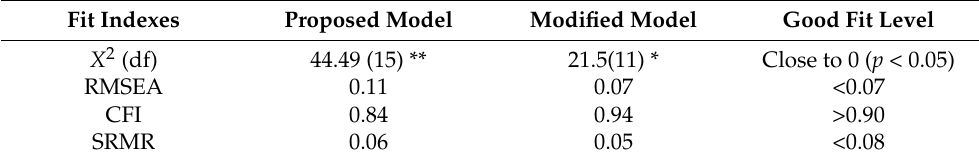
Table 3. Goodness of fit statistics for the proposed and modified model with acceptable